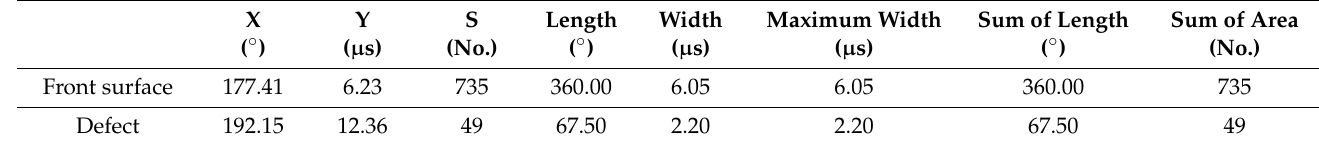
Table 4. Geometric feature information of selected chapped defect